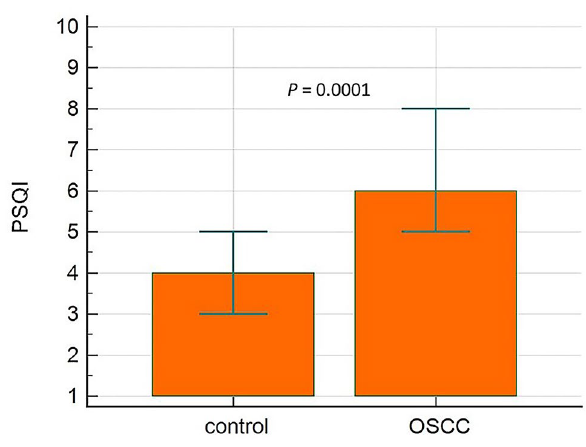
Figure 2. Pittsburgh sleep quality index (PSQI) comparison between the oral squamous cell carcinoma patients (OSCC) and the control group expressed with median and 95% confidence interval for the median.